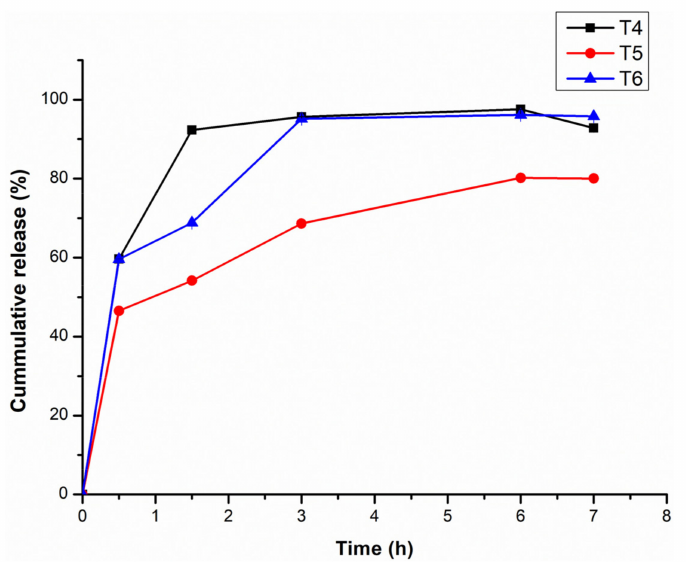
Figure 5. Cumulative release profile of CBD from the transferosomes over a period of 7 h at 37 ◦ C. ( n = 3) for T4: CBD-loaded transfersomes with 25 mg polysorbate 80, T5: CBD-loaded transfersomes with 50 mg polysorbate 80, and T6: CBD-loaded transfersomes with 100 mg polysorbate